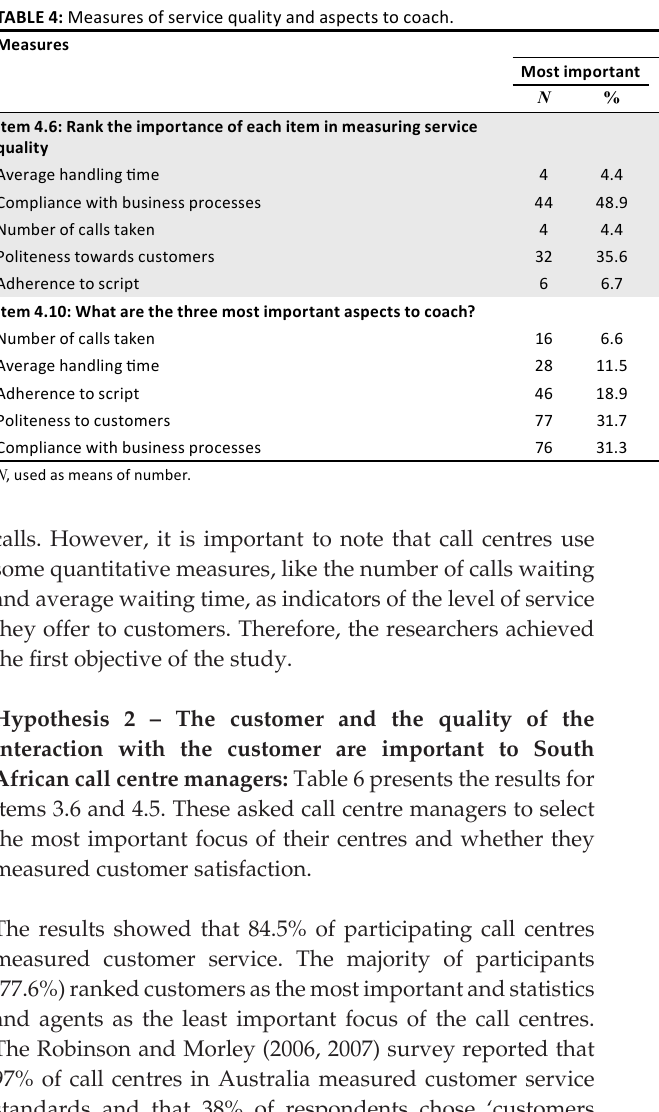
N , used as means of number.